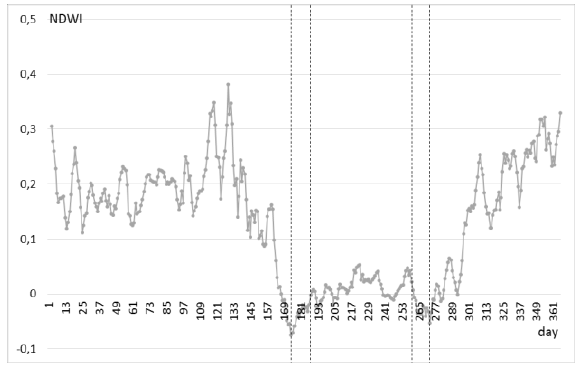
Figure 1. Example of 1-day temporal resolution annual graph of NDWI; Dashed vertical lines separates (from left to right) spring, summer and autumn growing